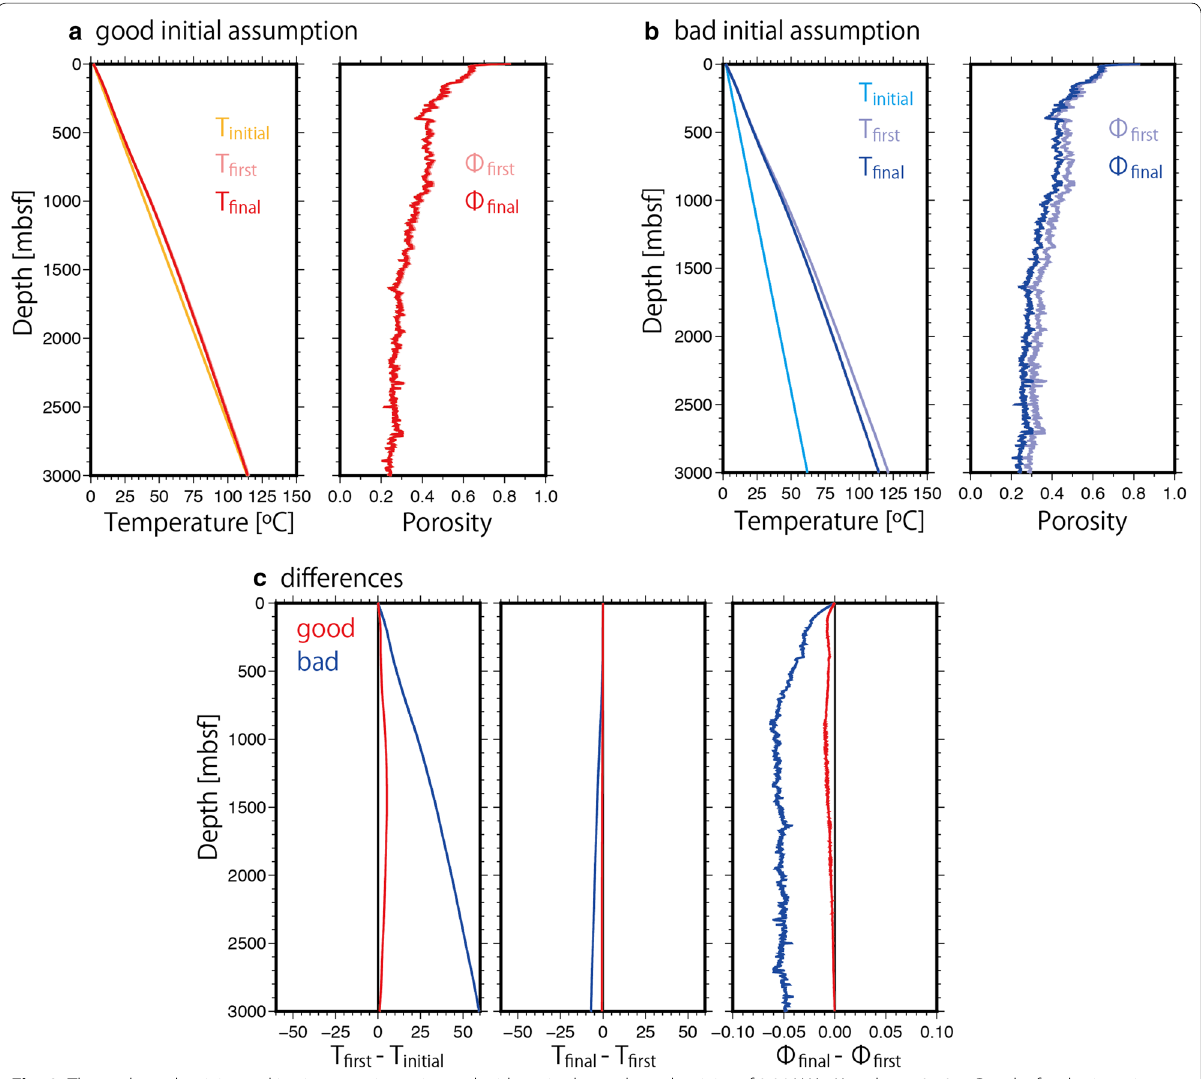
Fig. 8 Thermal conductivity and in situ porosity estimated with grain thermal conductivity of 2.29 W/mK and m estimation started with a good initial assumption on the thermal structure. The left and right panels show depth profiles of temperature and in situ porosity, respectively. For the thermal structure, the initial assumption ( T inital ), the first iterative step ( T first ), and the final estimation ( T final ) are shown. For the in situ porosity, the one estimated in the first iterative step (φ first ) and the one finally estimated (φ final ) are shown. b Same as a , but with a bad initial assumption for the thermal structure. c Differential depth profiles of T first are for good and bad initial assumptions,